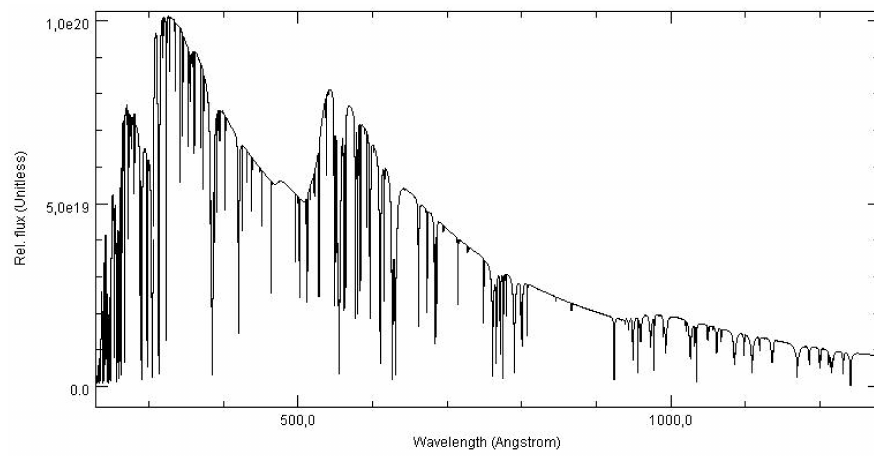
Fig. 3. A TheoSSA spectrum displayed with SPECVIEW.